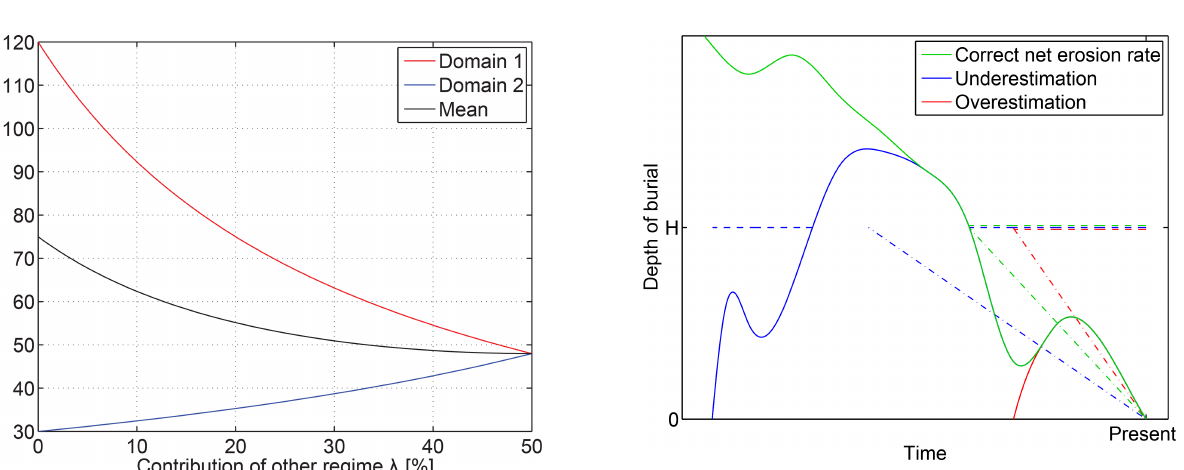
Figure 10. Estimated erosion rates if Earth consisted of two equally sized parts with erosion rates r h = 120mMyr − 1 and r l = 30mMyr − 1 . It is assumed that two, also equally sized, domains are analyzed separately, where the major part of domain 1 has the ero- sion rate r h and the major part of domain 2 has the erosion rate r l , but each of the domains contains a given contribution λ of the other erosion rate (Eq. 8).